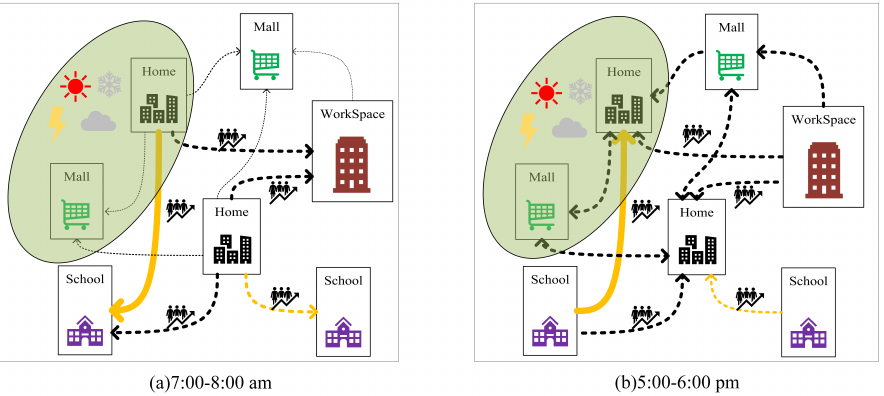
Figure 1. An example of different relationships among